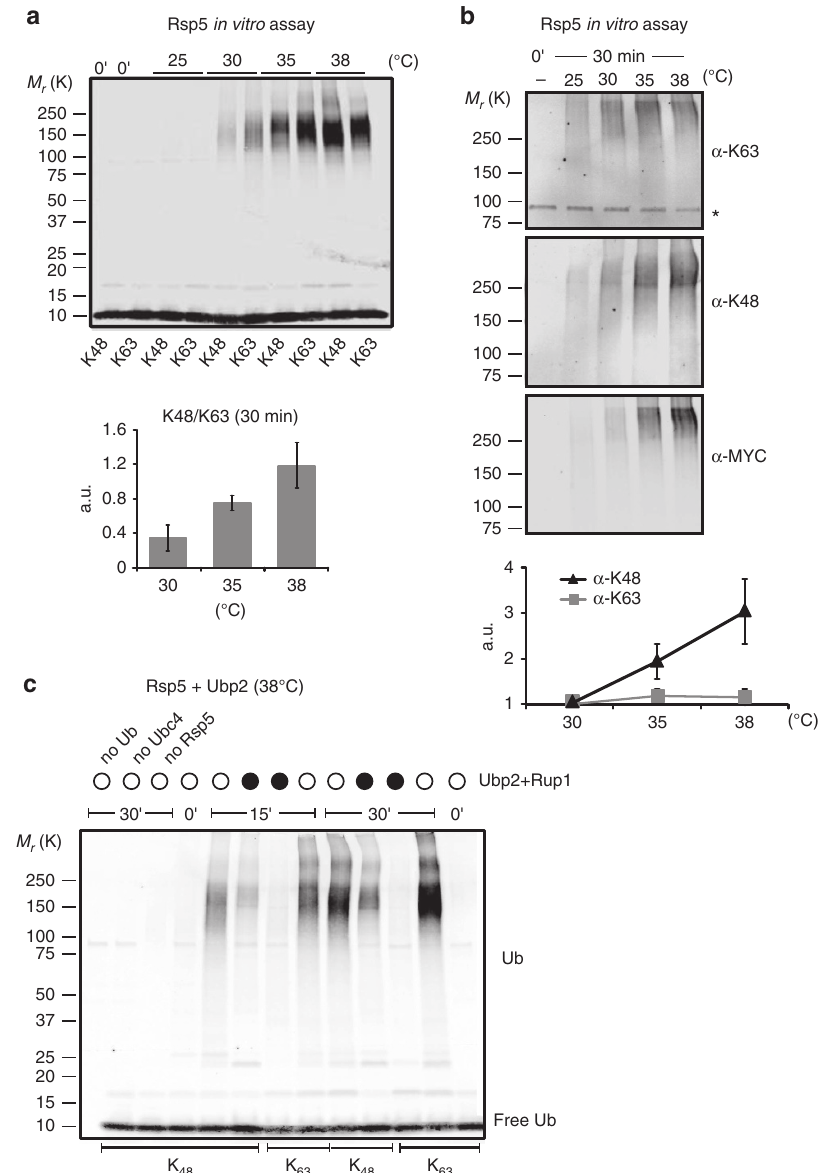
Figure 6 | Rsp5 specificity is altered at higher temperatures and promotes K48 chains assembly in the presence of Ubp2 in vitro . ( a ) In vitro Rsp5 auto- ubiquitination assay for 30min at the indicated temperatures with His 6 -tagged K48-only (K48) or K63-only (K63) ubiquitin variants, followed by anti- ubiquitin western blots. Histograms (right) show quantification of K48 versus K63 levels ( 4 100kDa) from three independent experiments (with s.d.). Levels at 25 (cid:2) C were too close to the background for quantification. ( b ) In vitro Rsp5 auto-ubiquitination assay at the indicated temperatures for 30min with the Myc-tagged ubiquitin followed by western blots with anti- K63 chains, K48 chains and Myc antibodies. Asterisk denotes an unspecific band. Relative levels were quantified in three independent experiments (with s.d.). ( c ) In vitro Rsp5 auto-ubiquitination assay at 38 (cid:2) C incubated for 15 or 30min followed by western blot with anti-ubiquitin antibody. Unless indicated otherwise, the reactions were done in the presence of E1, Ubc4, Rsp5, His 6 -ubiquitin and an equimolar amount of Ubp2 and Rup1 (black